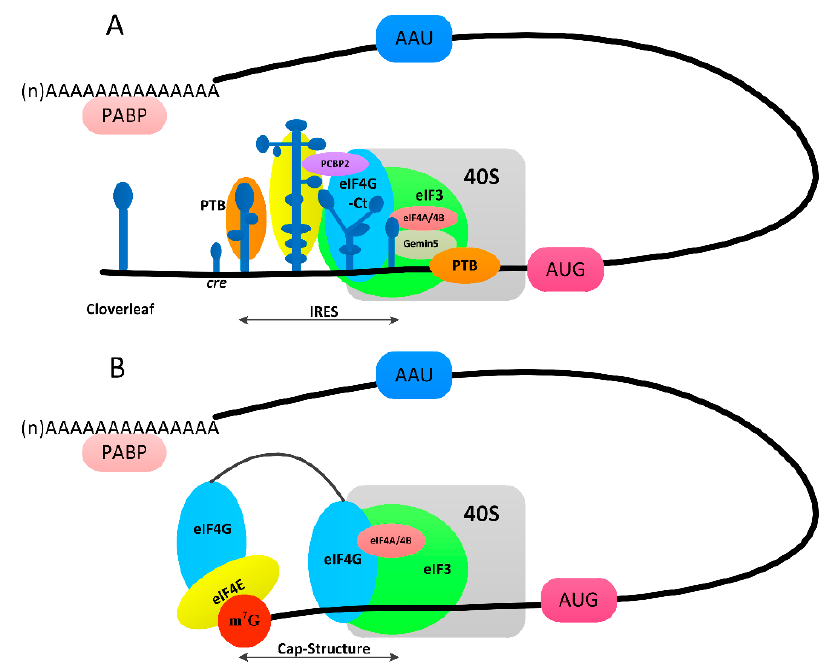
Figure 4. Type II IRES-dependent and cap-dependent protein synthesis initiation. ( A ) The RNA of FMDV employs a type II internal ribosome entry site (IRES) to recruit the 40S subunit to start translation. Some eIFs and ITAFs are required for IRES-driven translational initiation [60]; ( B ) The host cell employs the cap-dependent protein system. The m7G(5 ′ )ppp(5 ′ )N structure is recognized by a translation initiation factor (eIF4F). The binding of eIF4F to the cap and the binding of PABP to the poly (A) tail circularize the mRNA to activate it [60]. Abbreviations include: eIF4G: eukaryotic translation initiation factor 4G; eIF4E: eukaryotic translation initiation factor 4E; PTB: polypyrimidine tract-binding protein; PCBP: poly (rC)-binding protein; PABP: poly(A)-binding protein; eIF3:translation initiation factor 3; m 7 G: 7-Methylguanosine.